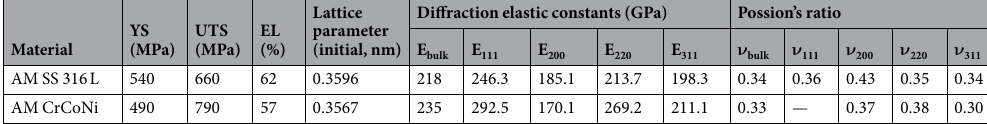
Table 1. Mechanical properties of yield strength ( σ y , MPa), ultimate tensile strength ( σ UTS , MPa), and elongation ( ε f , %) in engineering stress-strain curves of the AM SS 316 L and AM CrCoNi alloys. Summarized the initial lattice parameter ( a o , nm), diffraction elastic constant ( E hkl , GPa), and Possion’s ratio ( v hkl ) of each ( hkl ) plane. The E bulk and v bulk were obtained by Rietveld whole peak fitting of the a o evolutions. Note that the strain rate is 2 × 10 − 5 s − 1